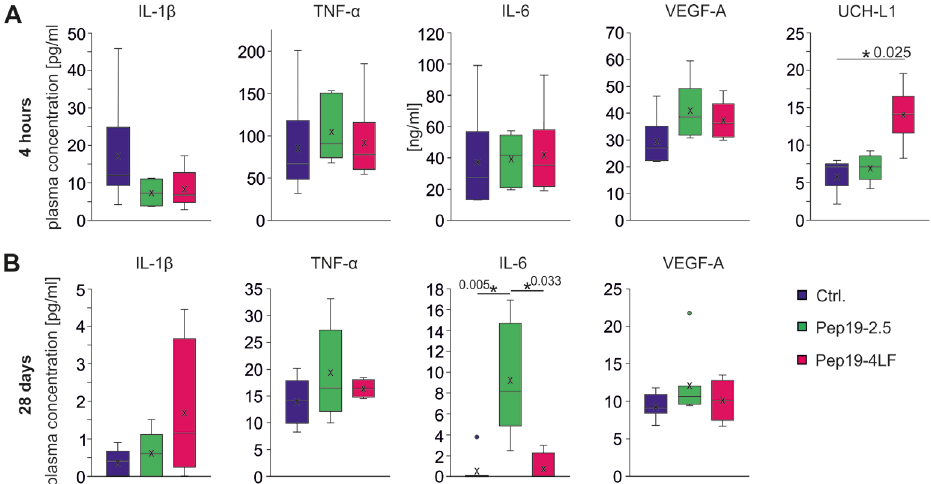
Figure 5. Plasma levels of IL- 1β, TNF - α, IL -6, VEGF-A and UCH-L1 four hours ( A ) and 28 days ( B ) after CA-CPR. Measurements are shown in pg/mL (except IL-6 after 4 h in ng/mL). Plasma levels were assessed in each group and presented as boxplots showing the quartiles, the 5th and 95th percentiles (whiskers), the median (line) and the mean (x). ( A ) Four hours after CA-CPR, plasma levels of cytokines and VEGF-A were measured at an elevated level compared with 28 days after CA-CPR ( B ). Differences in the comparison of the groups (each n = 6, unless otherwise specified) could not be detected with regard to cytokines (IL- 1β: p = 0.109; TNF- α: p = 0.423; IL-6: p = 0.519) and VEGF-A ( p = 0.076). UCH-L1 levels in the Pep19-4LF treated group (n = 5) were significantly higher than in the control group (n = 4, p = 0.025). ( B ) All plasma levels of cytokines and VEGF-A 28 days after CA-CPR were normally low. For IL-6, the group of mice treated with peptide Pep19-2.5 showed significantly higher concentration after CA-CPR ( p = 0.003; pairwise: Ctrl. (n = 8) vs. Pep19-2.5 (n = 7), p = 0.005; Pep19-4LF (n = 4) vs. Pep19-2.5: p = 0.033; Ctrl. vs. Pep19-4LF: p = 0.864).